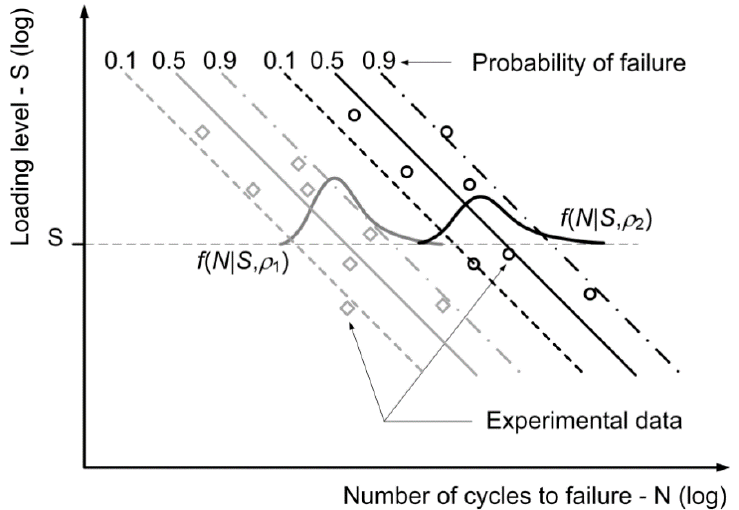
Figure 3. Fatigue-life curves with scatter for different densities of